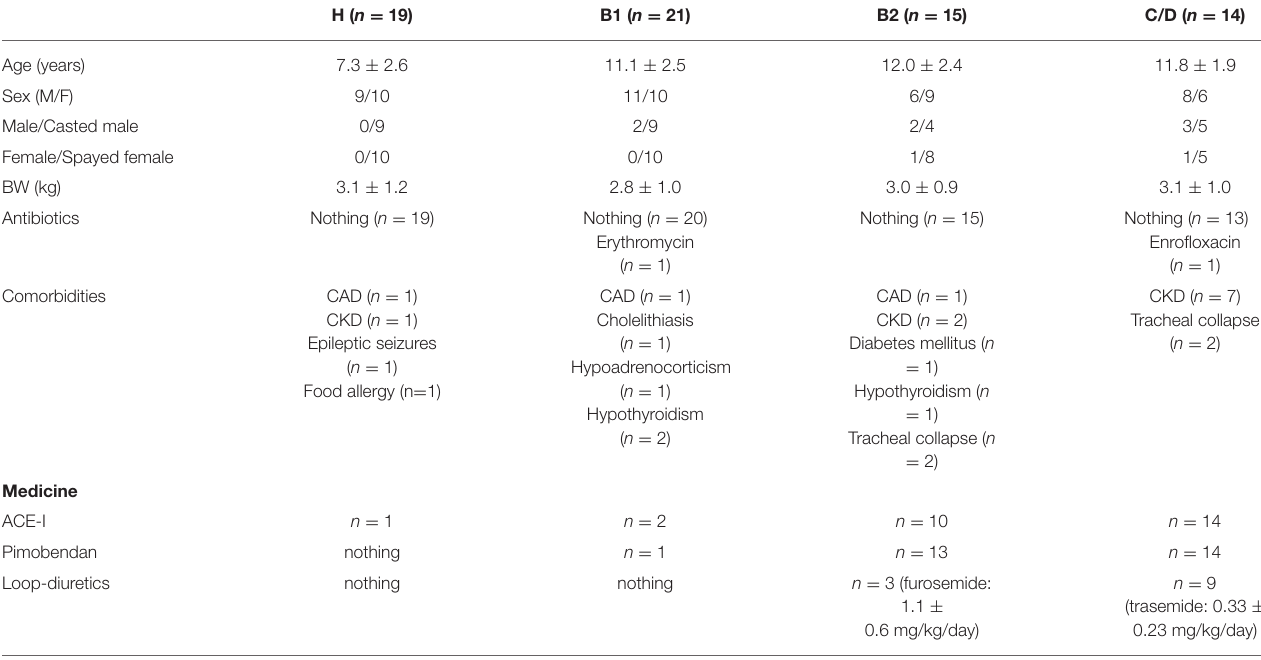
TABLE 1 | Patient characteristics of healthy Chihuahuas (H) and Chihuahuas with myxomatous mitral valve disease divided into three groups (B1, B2, and